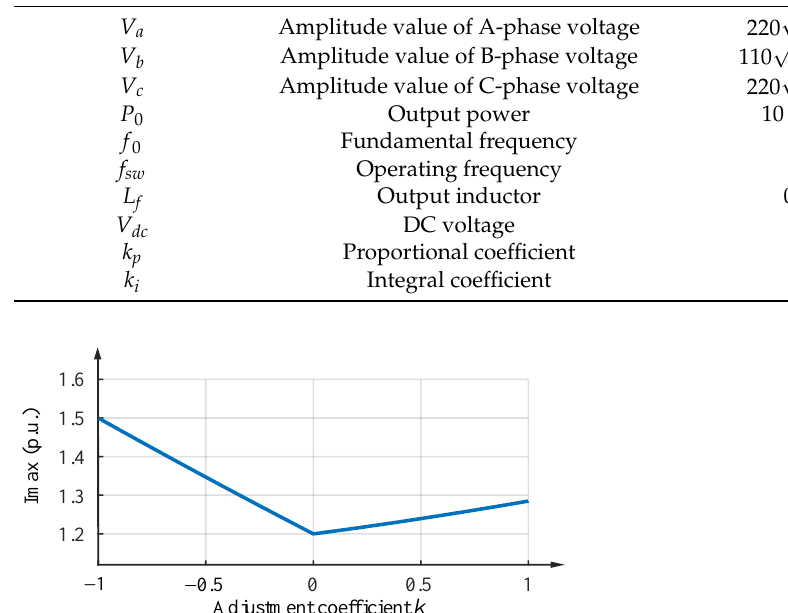
Figure 1. Maximum value of output current amplitude varying with the adjustment coefficient.